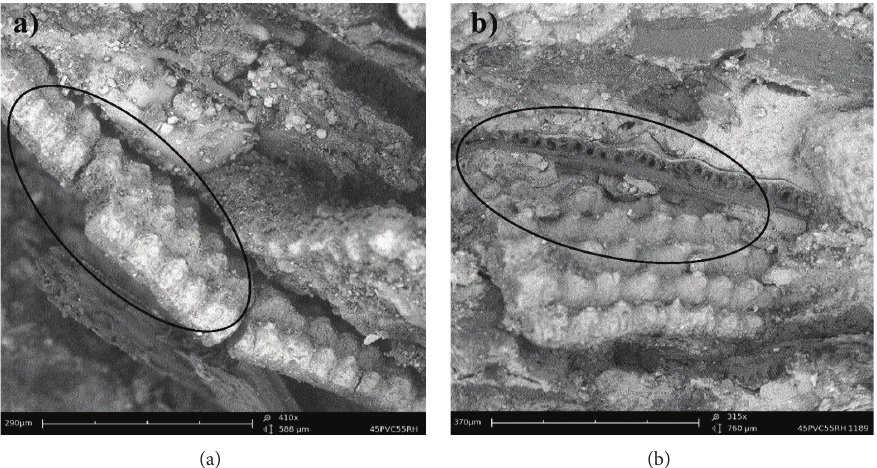
Figure 28: SEM micrographs of RH/rPVC composites (55% RH + 45% rPVC) (a) without the addition of aminosilane and (b) with addition of aminosilane